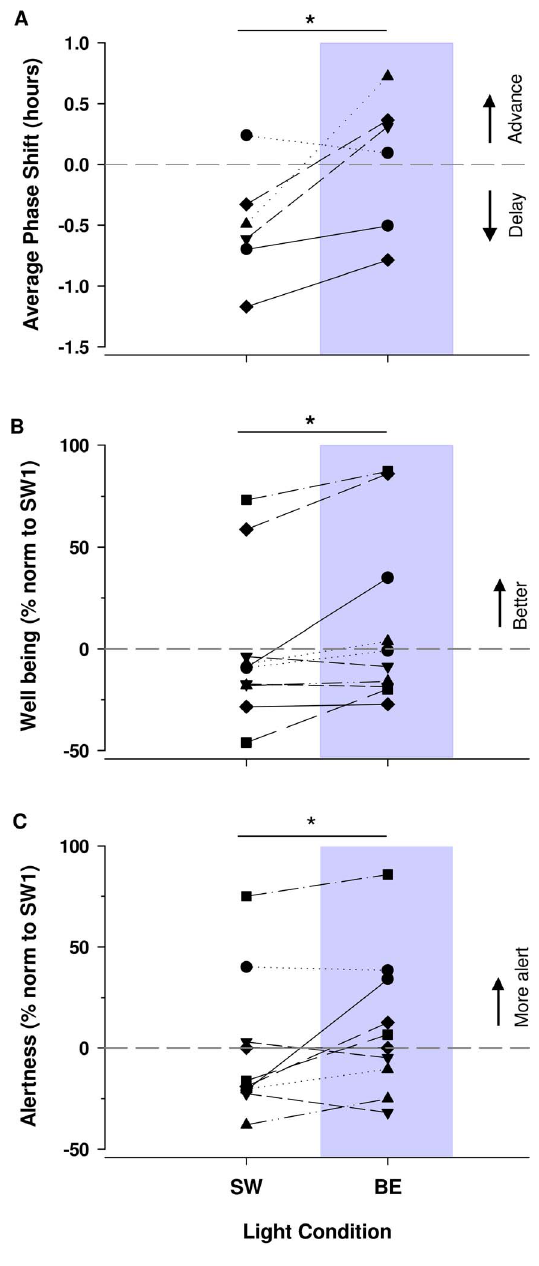
Figure 5. Impact of BE versus SW light on each participant’s phase shift, subjective well being and alertness. Results were normalized to week SW1. Circadian phase advances (positive phase shifts) and delays (negative phase shifts) and increases and decreases in well being and alertness were averaged over the weeks of the same light condition (SW versus BE). A . On average DLMOs were significantly delayed during SW light weeks compared to BE light weeks (p , 0.05). Average subjective well being ( B ) and alertness ( C ) were significantly increased under BE light weeks compared to SW light weeks (p , 0.05).